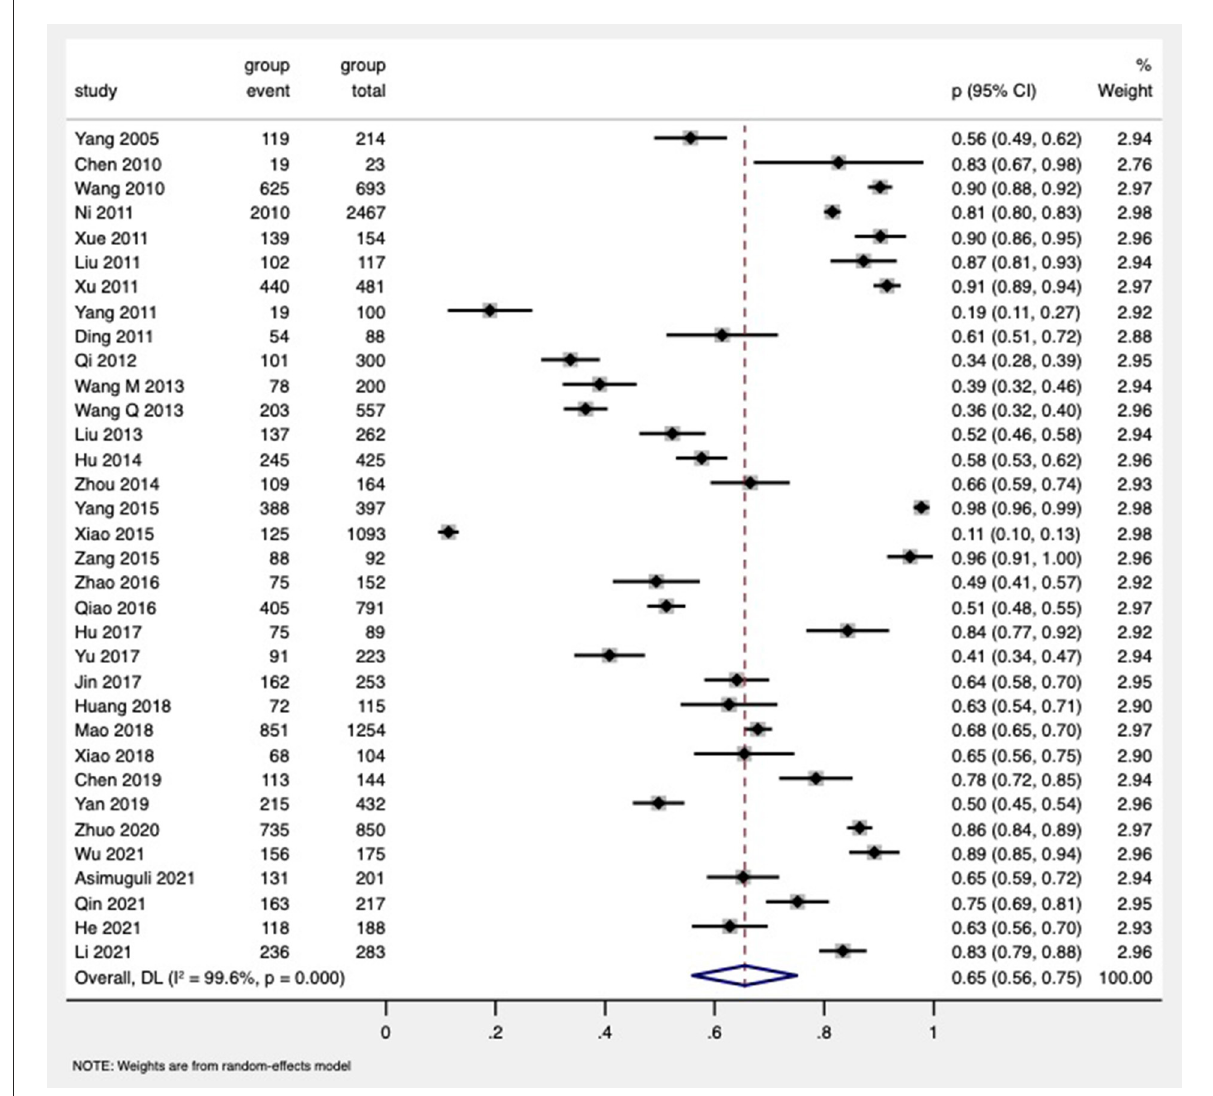
FIGURE2 Forest of the pooled proportion of HIV disclosure to sexual partners of PDWH in China.